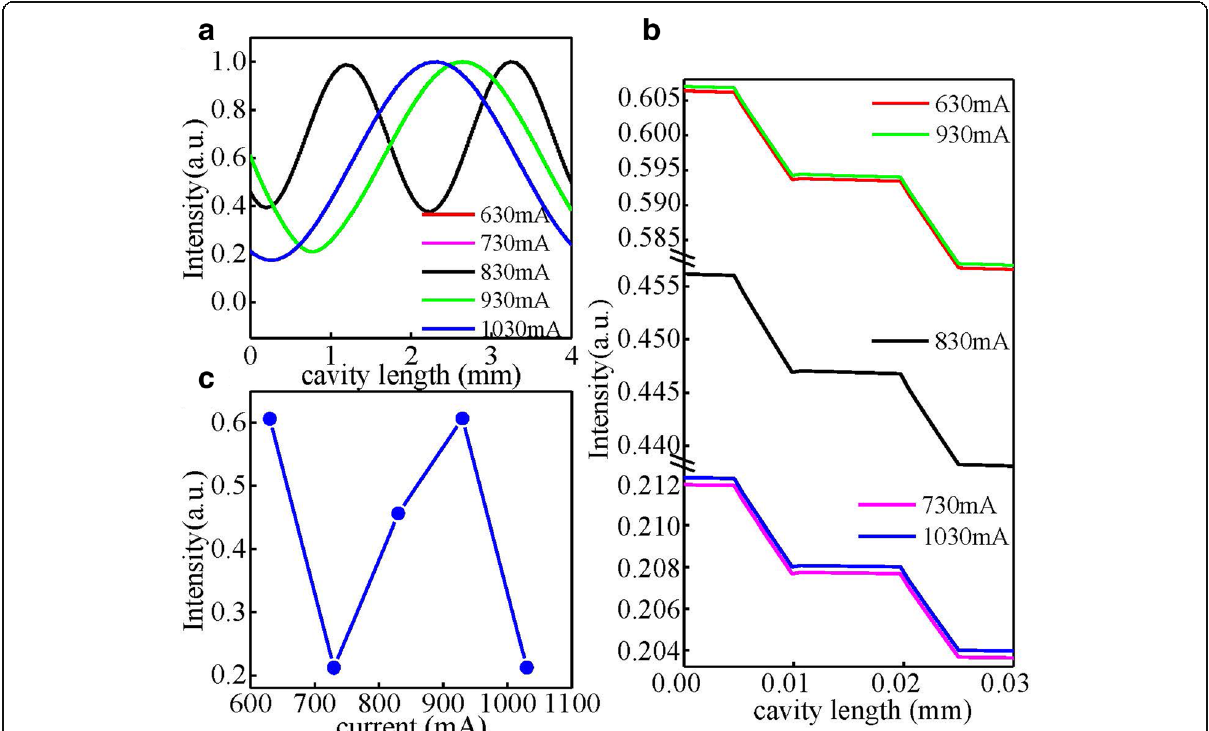
Fig. 4. a The simulated optical field distribution of the sampling grating at different injection currents. b The amplification of the optical field distribution near one of the end facets. c The detailed variation of optical field relative intensity at the end facet with injection